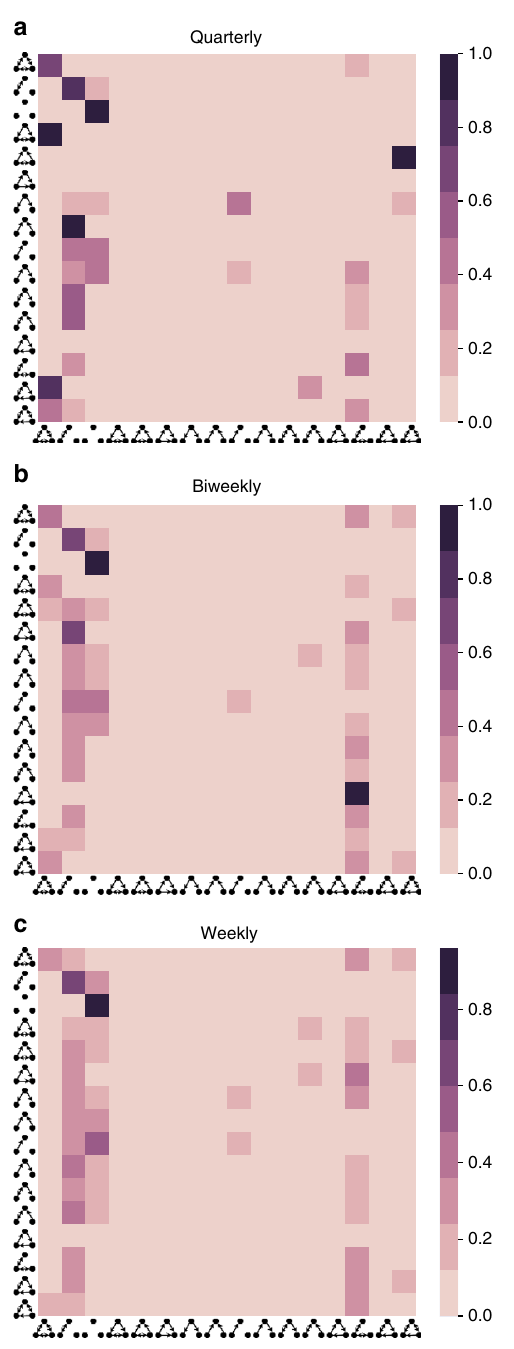
Fig. 7 The aggregated stochastic Markov transition matrix of all periods together, with a quarterly, b biweekly, and c weekly periods (i.e., the quarterly matrix shows the average of all matrices given in Fig. 2). Other designations are as Fig. 2). The transition probabilities are robust regardless of the choice of the period